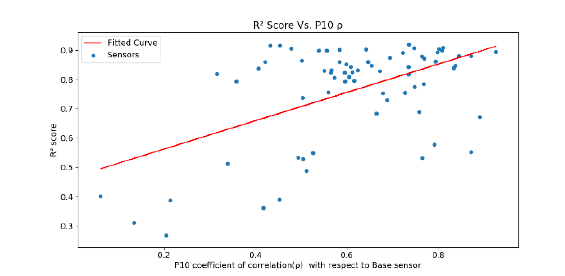
Figure 12. PM 10 Correlation and R 2 Score